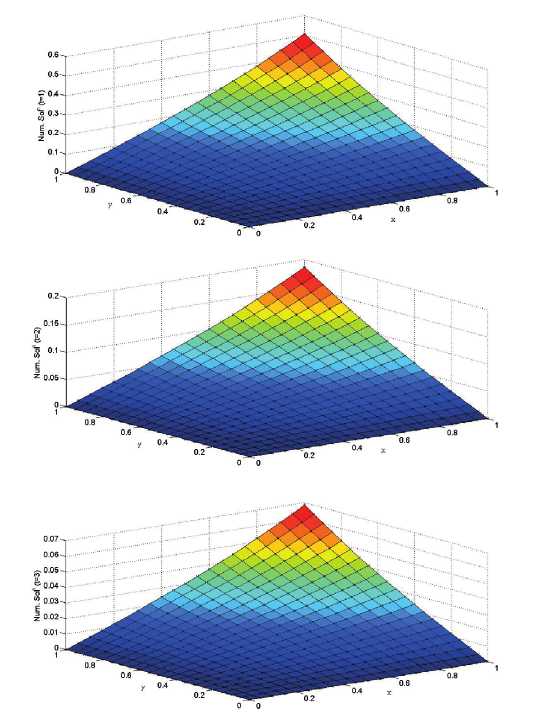
Fig. 2: Plots of numerical solution at different time levels for Exam- ple 5.1